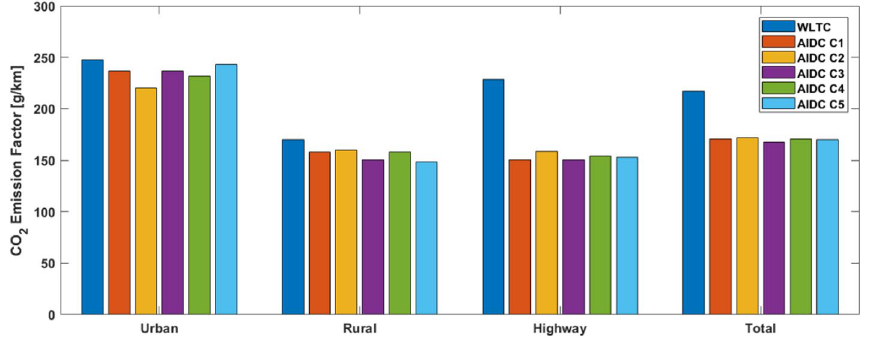
Fig. 9 Variation of CO 2 emission factors by segments and